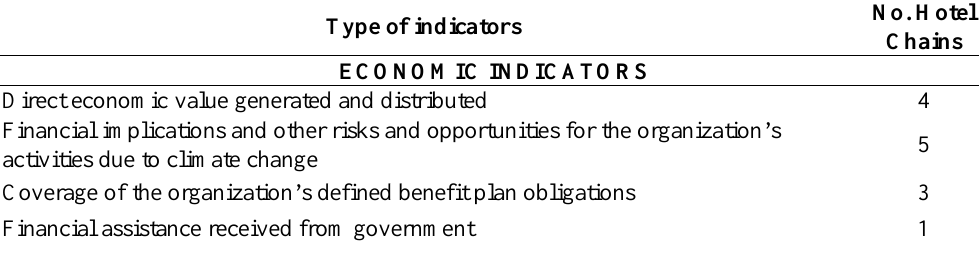
Table 4: Economic, Environmental and Social Contents Type of